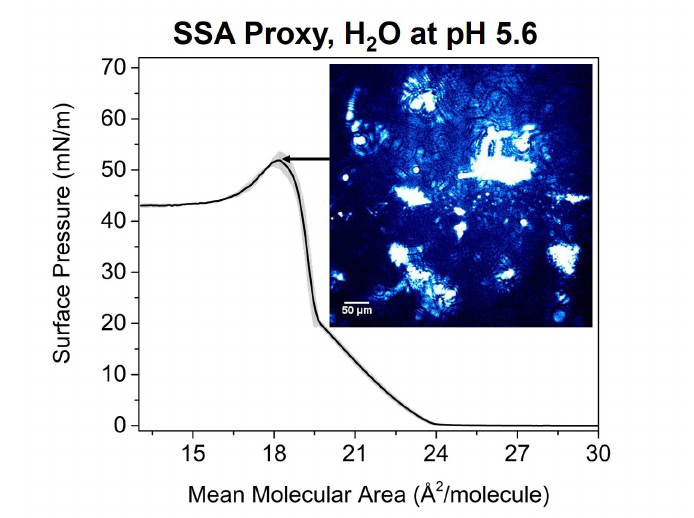
Figure 3. Π − A isotherm of the SSA proxy film on H 2 O at pH 5.6 and a BAM image of the monolayer collapse. The BAM image scale bar is 50 µ m (see Supplementary Materials).